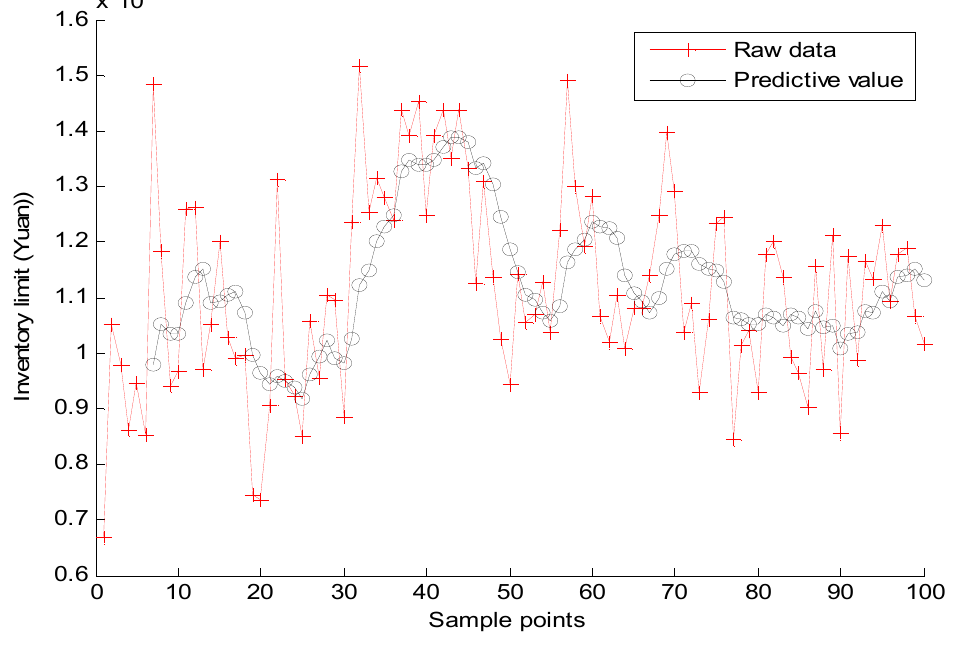
Figure 2. Predictive results of the first moving average method in 2011.